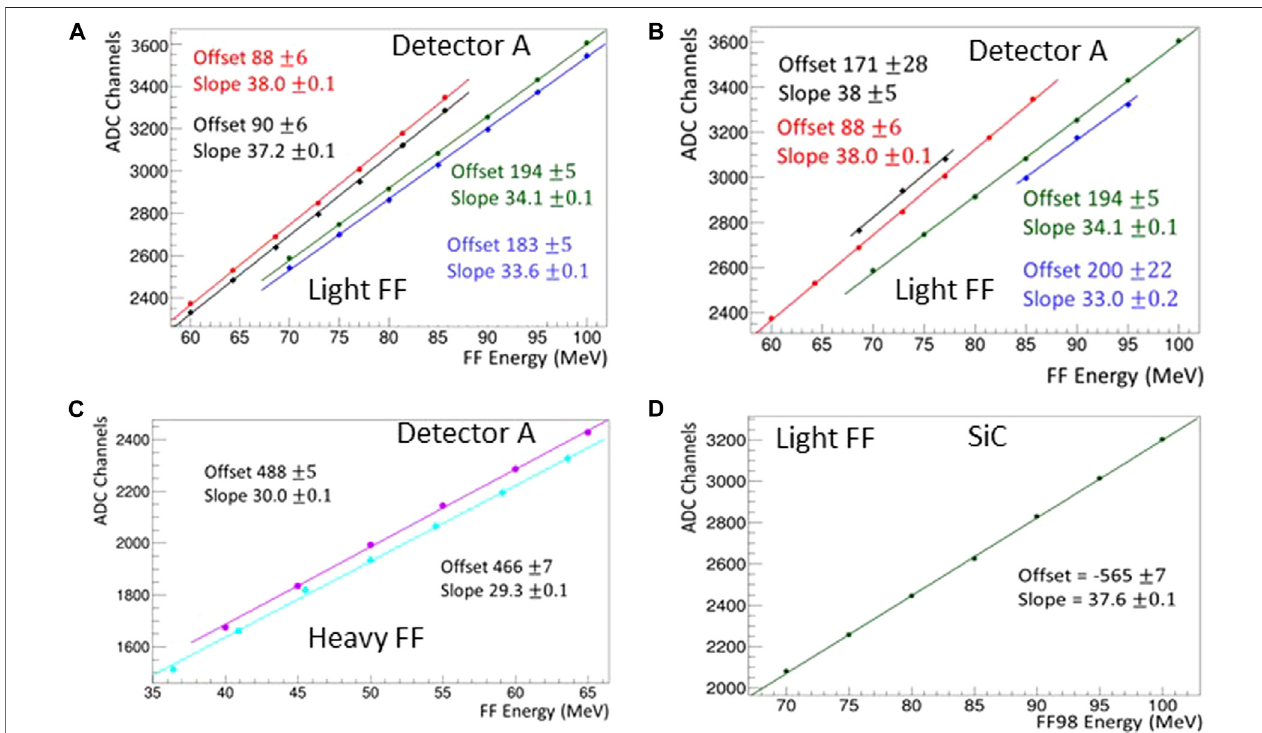
FIGURE 9 | The ADC peak channel versus incident FF energy is plotted. In (A) : diamond A linearity curves are drawn for FF98 (green and blue) and FF84 (red and black).Forgreenandredcurves,signalisreadonside0 ° ,whereas,forblackandbluecurves,signalisreadonside180 ° .Thediamondisbiasedto − 450 Vandside0 ° is exposedtoFFthatimpliesthattheelectronsignalismeasured. (B) Greenandredcurvesarethesameasin (A) ,darkandbluediffers:FFarenowimpingingside180 ° and diamondisbiasedto+450 V.Thattimetheholesignalisassessed. (C) ResponseofdetectorAtoFF131(lightblue)andFF144(pink),itisbiasedat − 450 Vandside 0 ° is exposed to FF (electron signal). (D) SiC detector linearity curves for FF98, the detector is biased to − 100 V (electron signal). For all plots, error bars are within the point